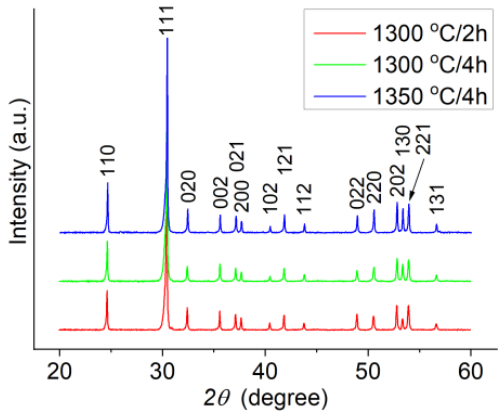
Figure 1. XRD (X-ray diffraction) patterns versus sintering condition for ZST ceramics.